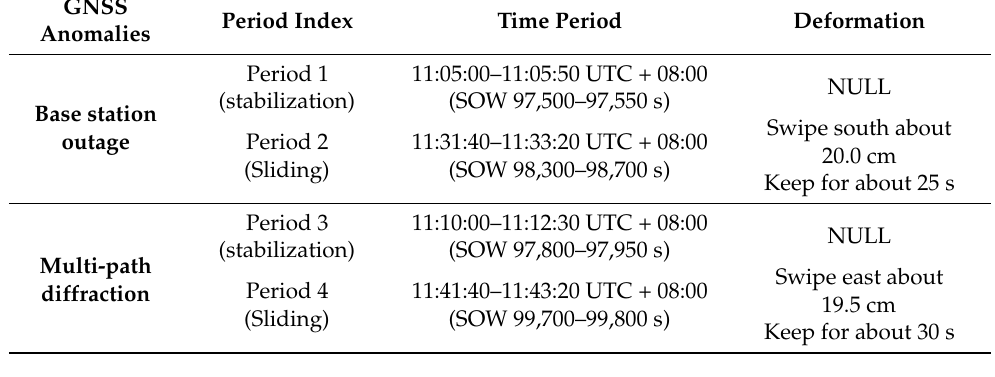
Table 5. Records of simulated landslide experiments in four groups of GNSS anomalies.